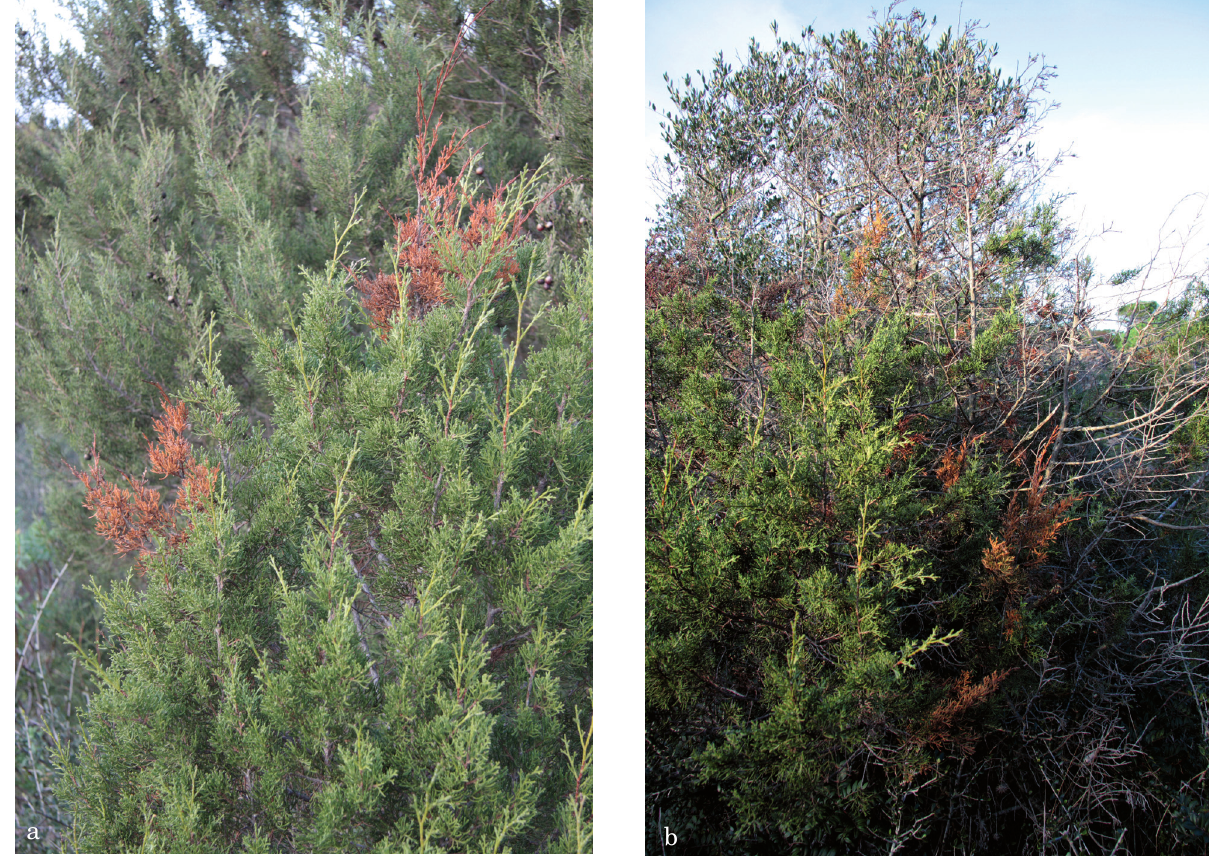
a Figure 1. Early dieback symptoms on branches of a Phoenicean juniper tree (a). Extensive twig and branch dieback (b).